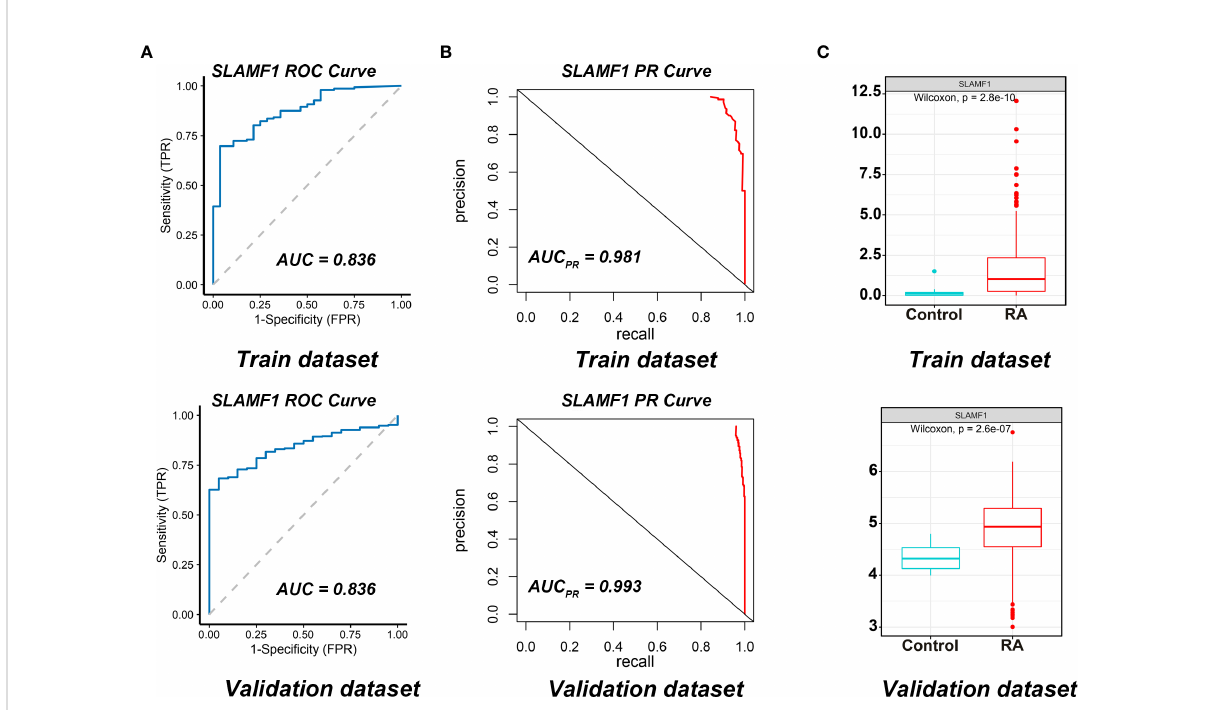
FIGURE 6 Diagnostic effect of SLAMF1 on RA. (A) ROC curve and (B) Precision-recall evaluation of the diagnostic effectiveness of SLAMF1 biomarkers in Train Dataset (GSE89408) and Validation Dataset (GSE45291). (C) The expressions of SLAMF1 in Train Dataset (GSE89408) and Validation Dataset